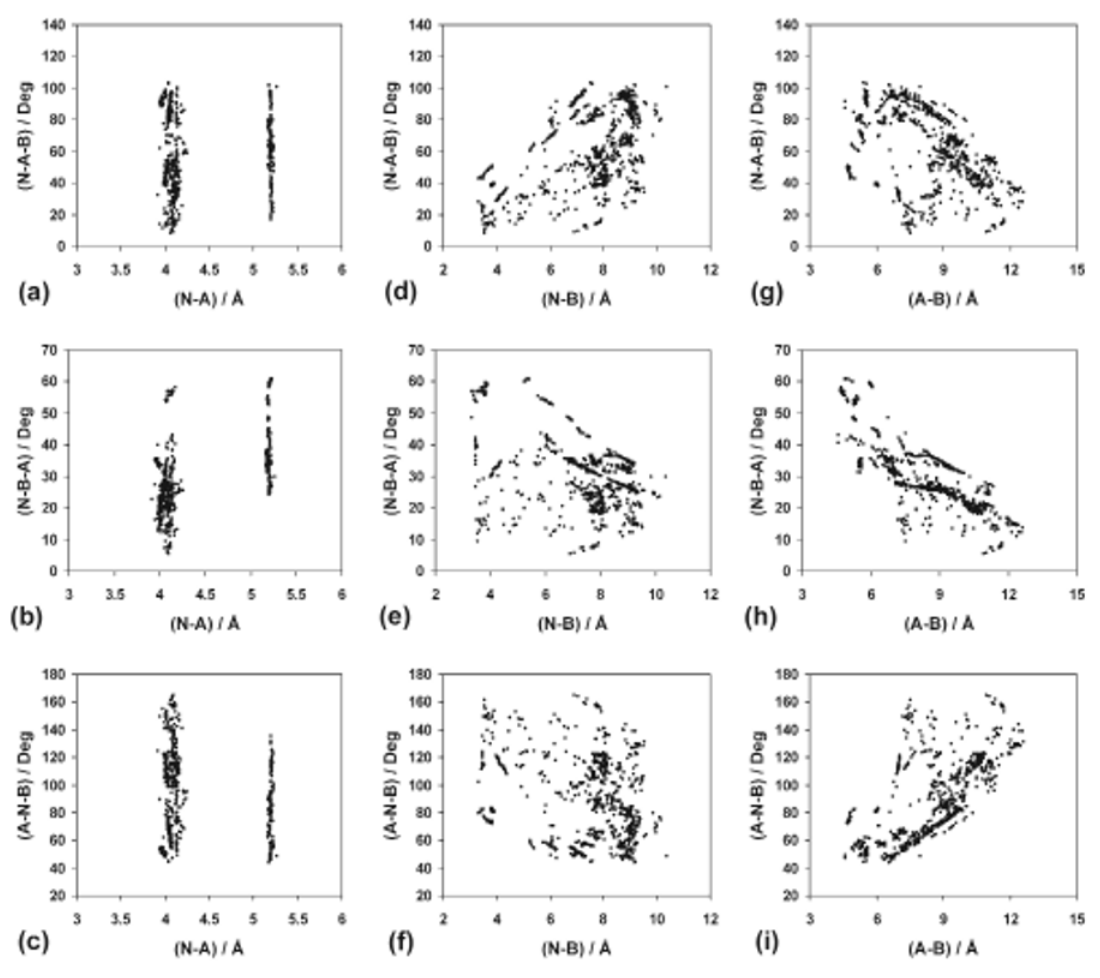
Figure 3. Nine different types of distance-angle maps, regarding the first subgroup of pharmacophore elements, for the S[2] stereoisomer: ( a ) the ( N-A ) – ( N-A-B ), ( b ) the ( N-A ) – ( N-B-A ), ( c ) the ( N-A ) – ( A-N-B ), ( d ) the ( N-B ) – ( N-A-B ), ( e ) the ( N-B ) – ( N-B-A ), ( f ) the ( N-B ) – ( A-N-B ), ( g ) the ( A-B ) – ( N-A-B ), ( h ) the ( A-B ) – ( N-B-A ) and ( i ) the ( A-B ) – ( A-N-B )